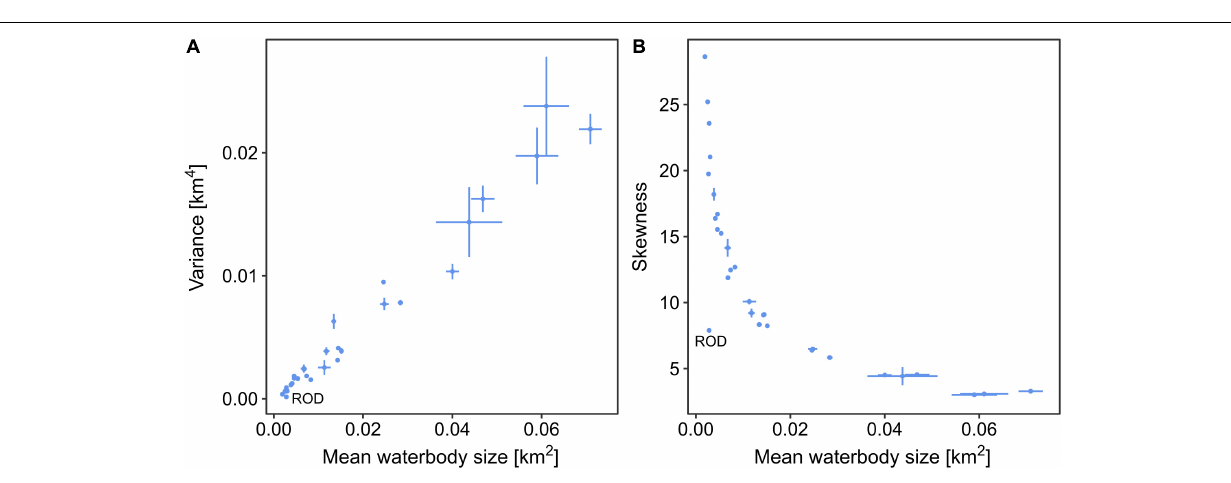
FIGURE 5 | Variations in the statistical moments of waterbody size distributions of the 30 Arctic study regions. The variance (A) and skewness (B) of the size distributions for each study region are plotted against the mean waterbody size. The moments are calculated for waterbodies with sizes between 0.0001 and 1 km 2 . The vertical and horizontal bars represent the standard deviation of the means of the mean size, variance, and skewness across 10 × 10 km subsets of the larger study regions (i.e., those covering 300 km 2 or more). The size distribution for waterbodies in the Cherskii-Rodinka region (ROD) is significantly less skewed than those for other regions with comparable mean waterbody